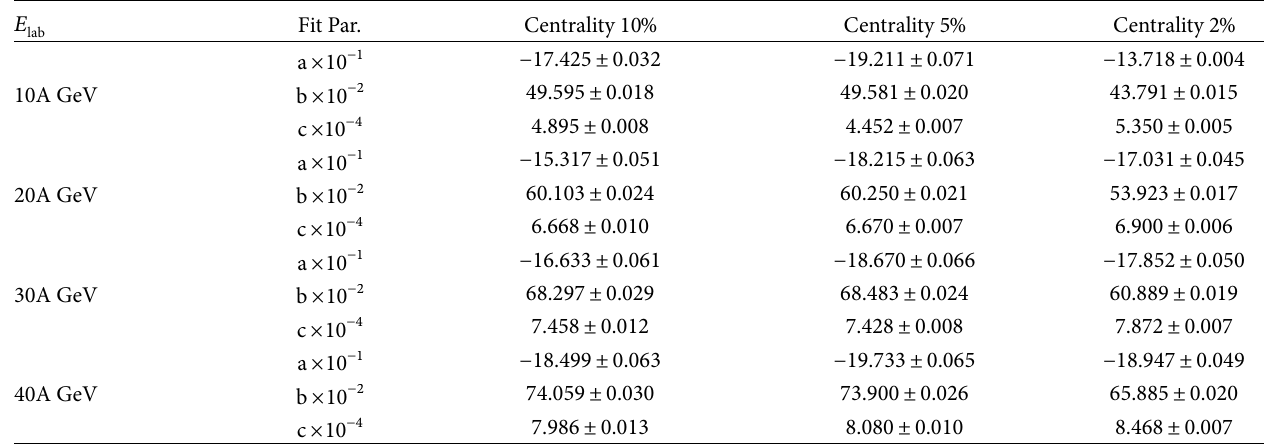
Table 5: Values of parameters, a, b, and c, occurring in equation (1) at different energies. Fit Par.